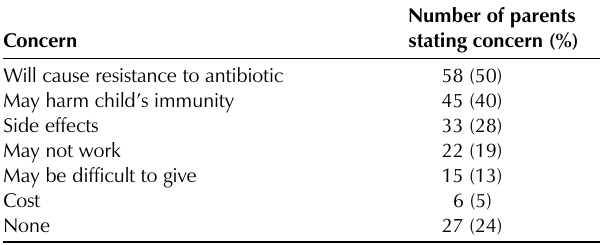
Parental beliefs about indications for antibiotics (n=114) Parental concerns about their child taking Number of parents stating that Condition